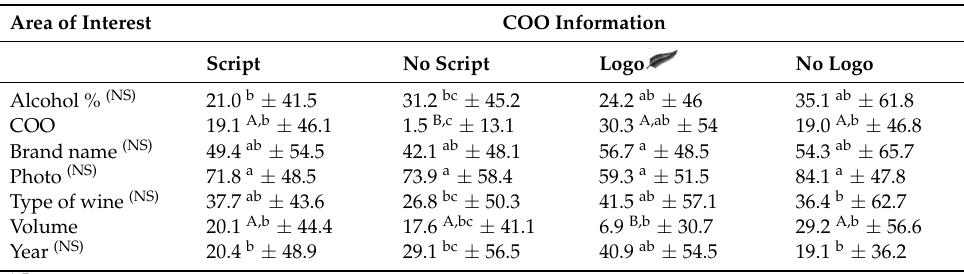
Table 3. Means and standard deviations of the average fixation duration (ms) on each AOI for four labels *.